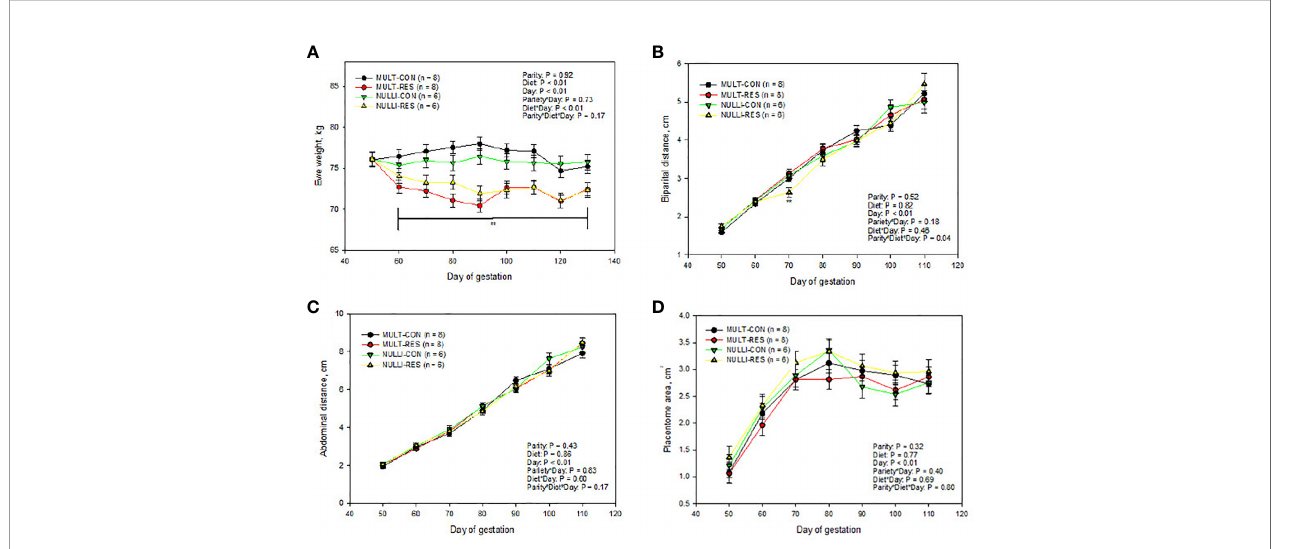
FIGURE 3 | Impacts of maternal nutrition on ewe weight (A) , fetal biparietal distance (B) , fetal abdominal distance (C) , and placentome area (D) from days 50 to 110 of gestation in multiparous (MULT) and nulliparous (NULL) ewes. CON = 100% of NRC recommendations. RES = 60% of CON from days 50 to 90 of gestation. Differences between CON and RES are denoted by **P ≤ 0.05, *P ≤ 0.10 within a day.